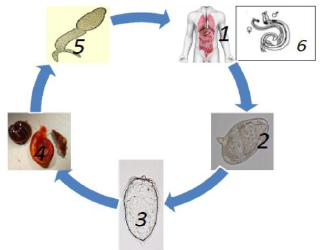
Figure 2. Life cycle of Schistosomes. 1 & 2 : Eggs excreted, either in the urine (in the case of S. haematobium ) and/or faeces (depending on the species) of infected individuals, begin the devastating cycle and eggs may stay viable for up to 7 days [4,10]. Only then do the eggs hatch in fresh water to become 3 : miracidia under the most favourable environmental conditions [3]. With the help of light and chemical stimuli, the miracidia burrow the tissue of a 4 : freshwater snail. Production of sporocysts and 5 : cecariae occur asexually over a period of 4–6 weeks and are released from the snail. The cercariae have forked or bifurcated tails and embryonic suckers and swim around until they come into contact with the human skin [4,18]. Thereafter, they shed their tails whilst simultaneously penetrating the epidermis to develop into larval forms called schistosomulae which remain in the skin for 48 h [3]. They then circulate the hepatic portal system via the bloodstream to mature into 6 : adults [19]. The worms then mate 28–35 days after infection, producing about 100–300 eggs per day (female S. mansoni and S. haematobium female worms) and 500–3500 eggs produced daily by S. japonicum worms which are released from the human host via defecation, thereby continuing the destructive cycle [20,21]. At this point, the disease seems species-dependent in that adults from S. mansoni and S. japonicum dwell in the mesenteric venous plexus causing hepatic and intestinal schistosomiasis; while adults belonging to S. haemotobium cause urinary schistosomiasis and reside in the perivesical venous plexus [22]. The worms are characterised by having a blind digestive tract, advanced neural, excretory and reproductive organs, two ending suckers and a greyish-white tegument that covers the 7–20 mm body of the worm [3,22]. Females reside in the gyneacophoric canal of the male and together form a nematode-like appearance